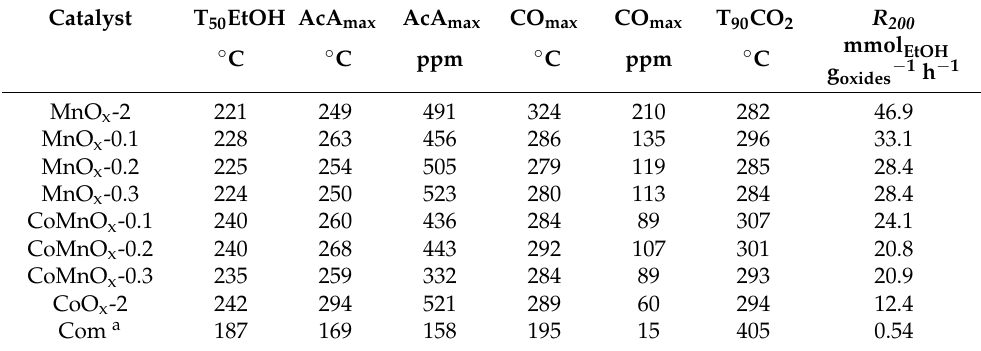
Table 6. Performance of the catalysts in ethanol oxidation (eight meshes, GHSV = 21 ± 1 L g cat − 1 h − 1 , 760 ppm of ethanol, temperature ramp 2 ◦ C min − 1